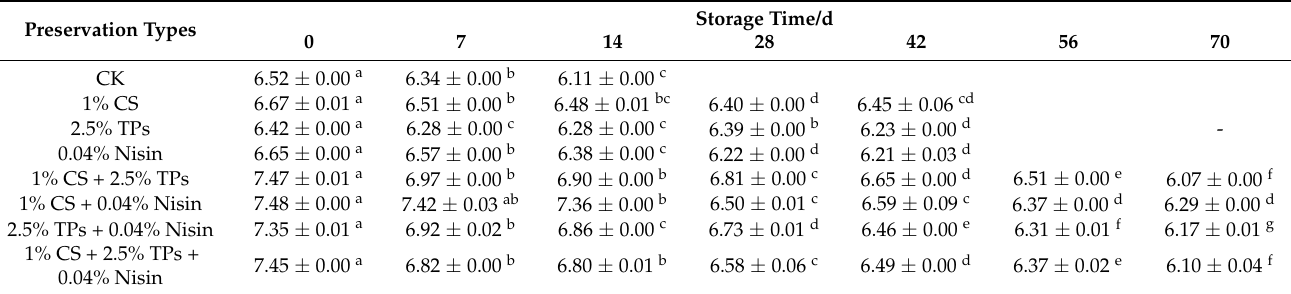
Figure 6. Effects of compound preservatives on the “b value” of plant-based meat. a–f Values with different superscripts in the same preservative indicate significant differences ( p < 0.05). CS, chitosan; TP, tea polyphenols; CK, control group. Table 2. Effects of compound preservatives on the pH of plant-based